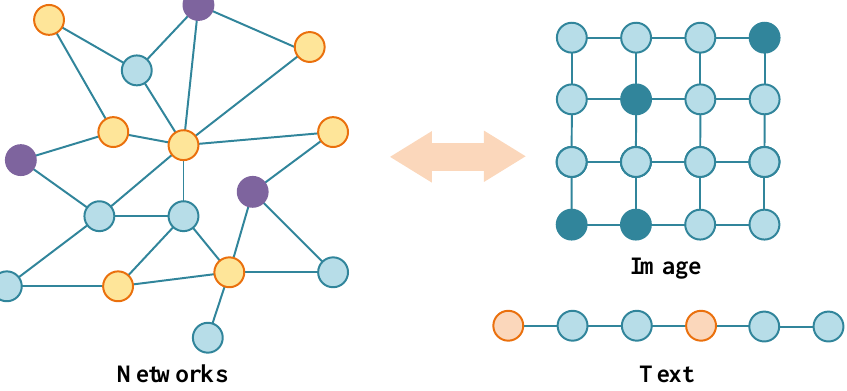
Figure 12. Euclidean structure data and Non-Euclidean structure